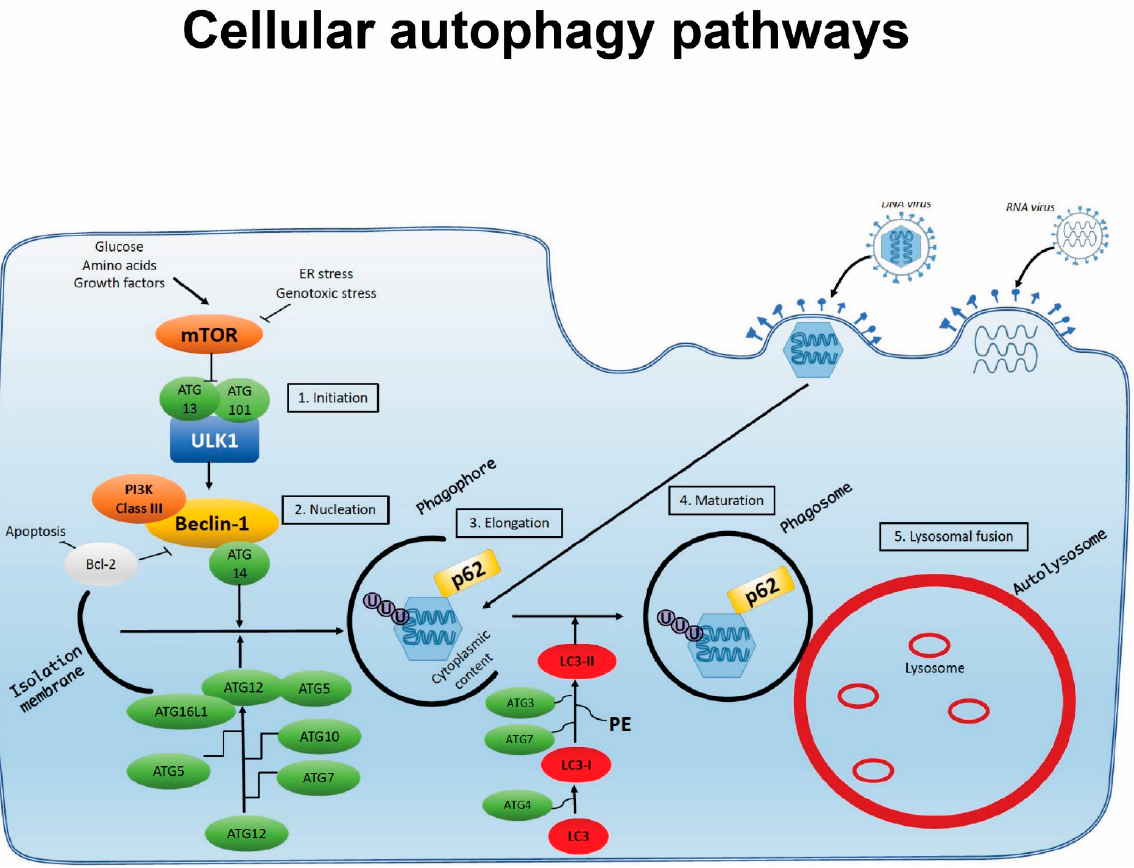
Figure 1. Cellular autophagy pathways. Autophagy is induced by cellular starvation, stress or microbial infection. The process involves the following steps: (1) initiation; (2) nucleation; (3) elongation; (4) maturation; and (5) lysosomal fusion, through which a double-membraned phagosome encapsulating cytosolic material is targeted for degradation after fusion with lysosomes to form an autolysosome. During infection, pathogens may activate autophagy pathways but also have the capacity to interfere with and exploit this process through interaction with specific autophagy proteins or steps in the autophagy process.